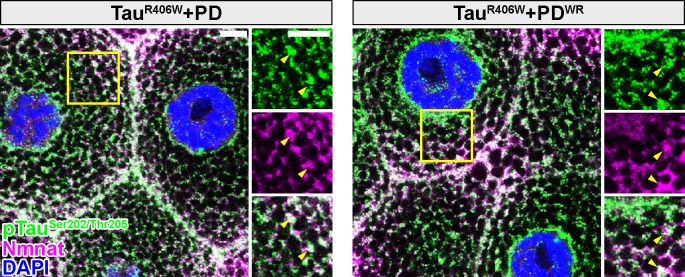
Drosophila Nmnat PD and PDWR colocalize with pTau in vivo.Third instar larval salivary gland cells expressing TauR406W with PD or PDWR by OK371-GAL4 were stained with pTau (green), Nmnat (magenta), and DAPI (blue). Yellow arrowheads indicate the colocalization of pTau with PD/PDWR. Scale bars, 10 µm.